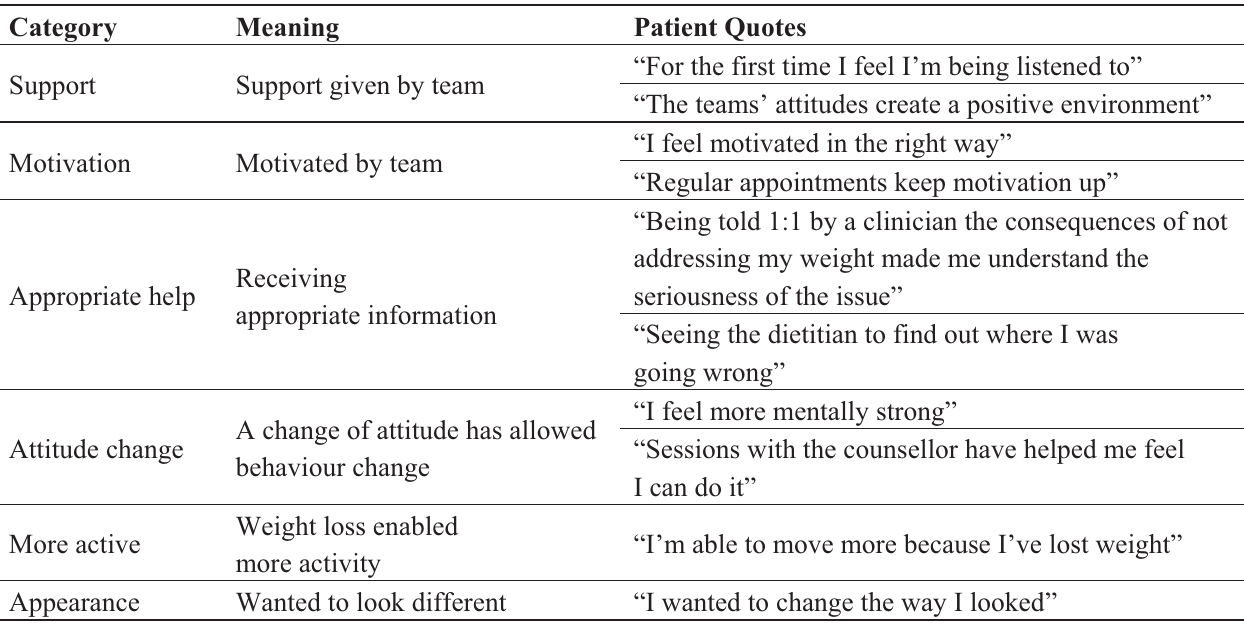
Table 11. Explanation of reasons given by patients for feeling encouraged to lead a healthier